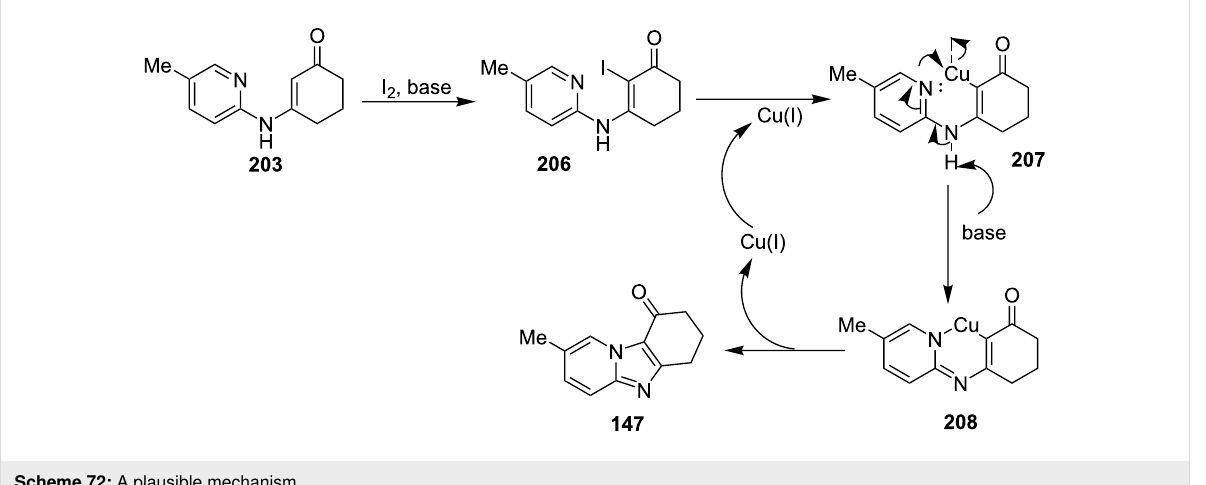
Scheme 72: A plausible